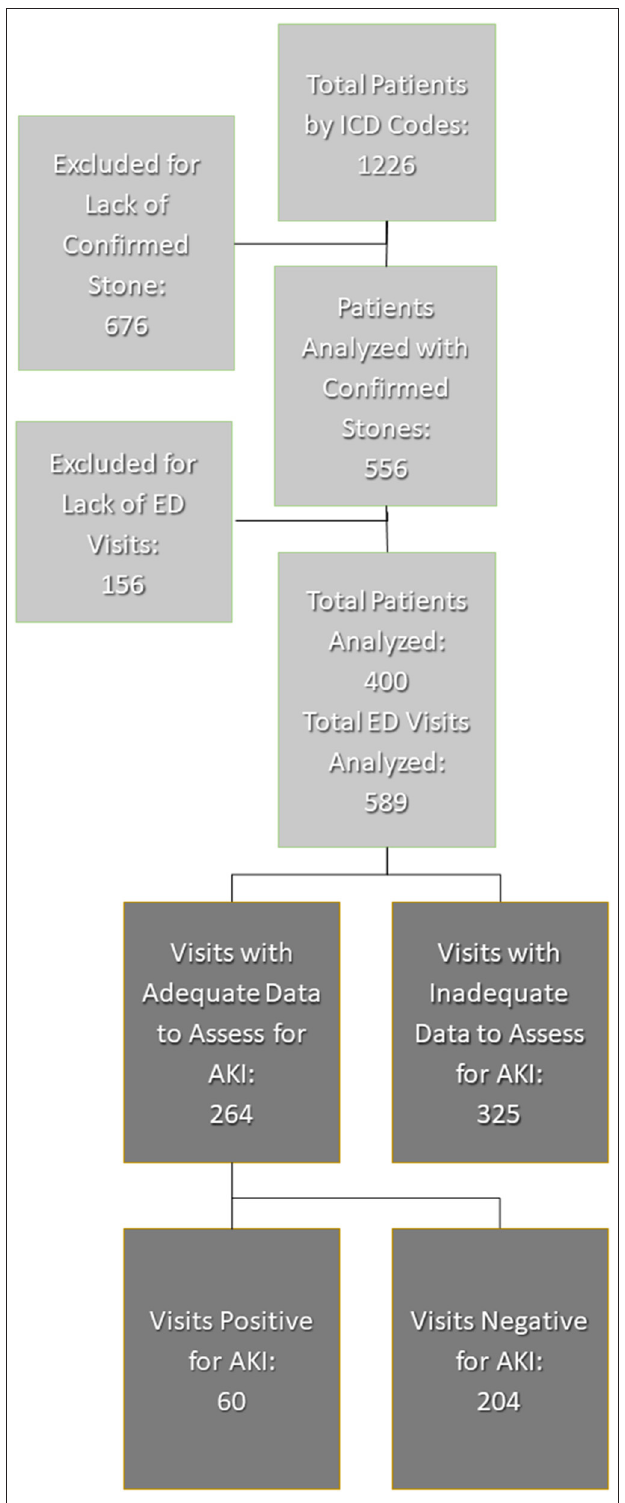
FIGURE 1 | Inclusion and exclusion of patient visits. AKI, acute kidney injury; ED, emergency